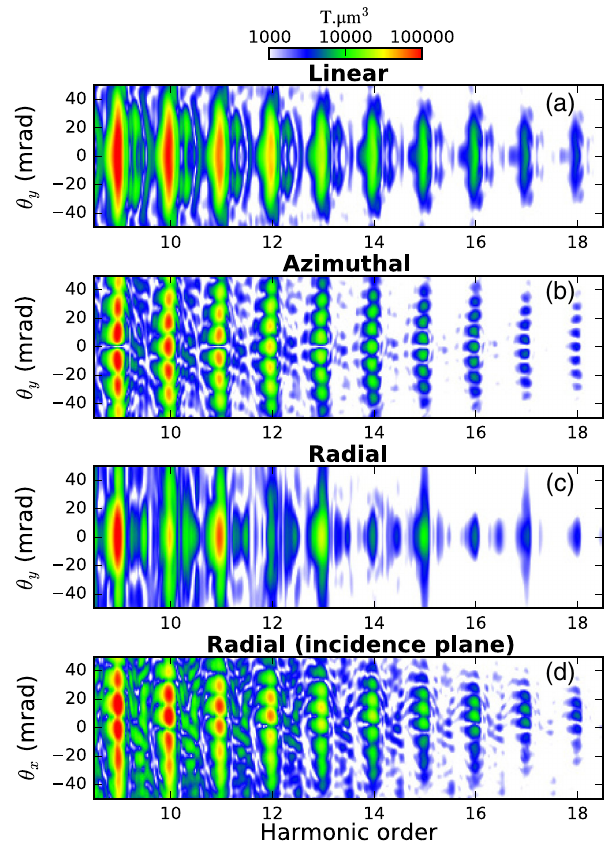
FIG. 4. Results from 3D PIC simulations. Angularly resolved harmonic spectra for (a) linear, (b) azimuthal, or (c),(d) radial polarization are shown. The angular dependence is shown with respect to the θ y angle in panels (a) – (c), which corresponds to the experimental case, and with respect to the θ x angle in panel (d) so that the interference pattern produced with a radially polarized beam becomes apparent. The spectra are obtained by calculating the spatial 3D Fourier transform of the B y field for the linear and radial polarization cases and of the E x =c= sin θ i field, where θ i is the incidence angle, for the azimuthal polarization case. We use R ⃗ k Þ ¼ f ð ⃗ r Þ e − i ⃗ k: ⃗ r d 3 ⃗ r to compute the Fourier the convention F ð R 3